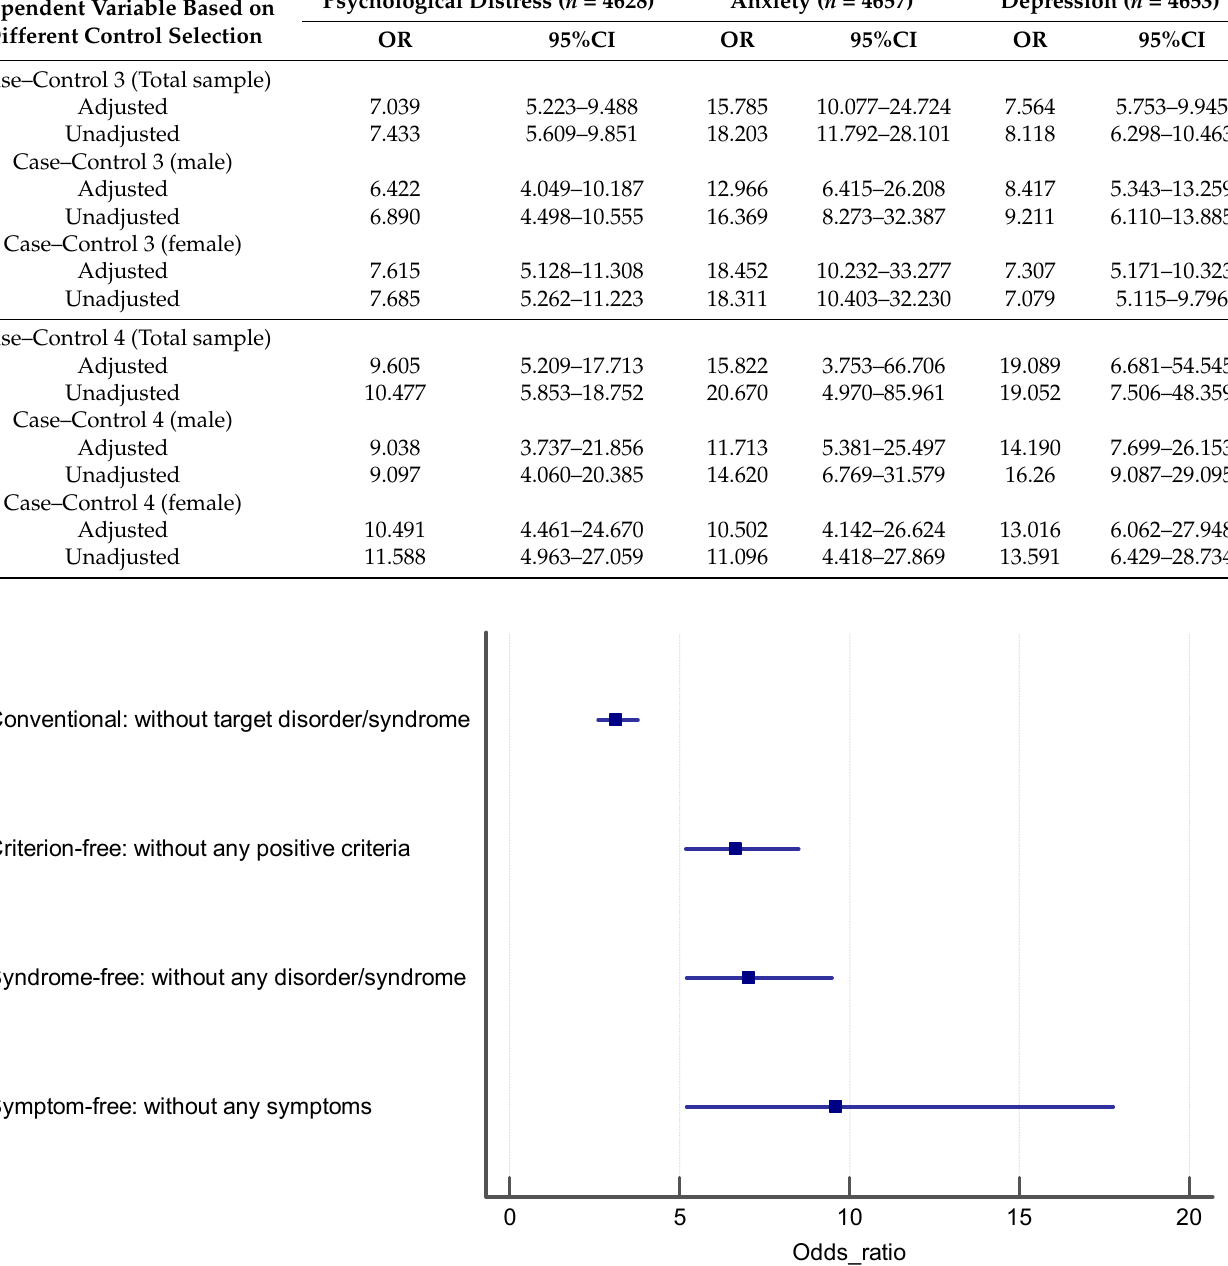
Figure 2. The estimated odds ratio for the association of psychological distress and FD in each control group.